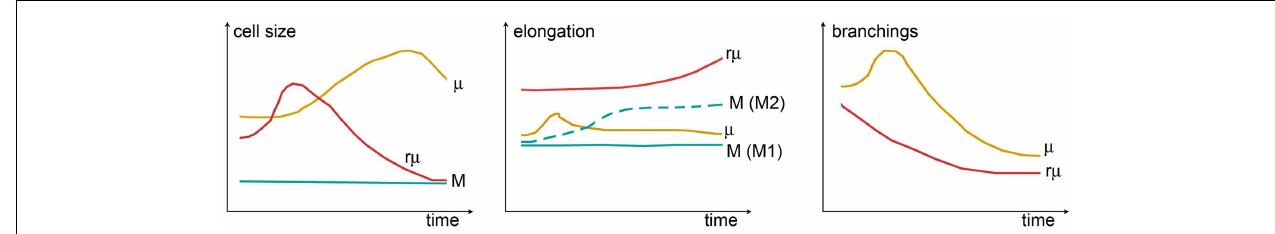
along with ameboid transformation, µ recover their symmetric shape. In contrast, r µ progressively elongates so as to align with axons.The rate of branching (right panel) can be measured by counting the number of ramifications or by Sholl analysis. M does not have ramifications, while µ or r µ withdraw branchings over time to acquire, respectively, the ameboid or the elongated morphology: µ show a transient increase of ramifications early after injury that may be related to damage-sensing activity. Shape changes have been plotted according to the data and observations described in Ref. (40, 118, 160, 161, 164,